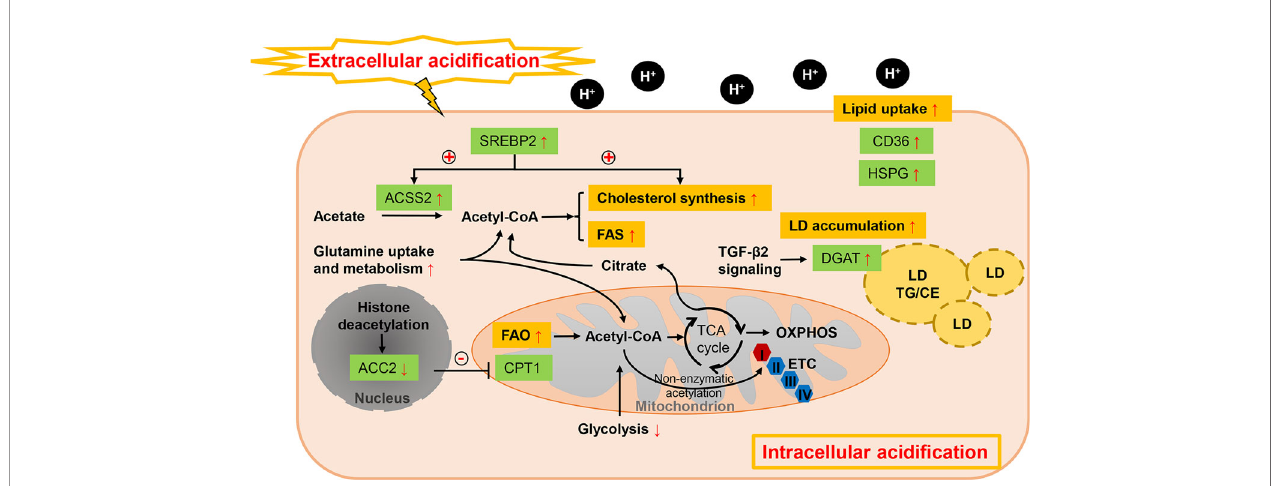
FIGURE 3 | Lipid metabolism reprogramming of cancer cells under acidosis. While glucose-derived acetyl-CoA is dramatically reduced, FA metabolism is profoundly altered in response to ambient acidosis with a shift toward FAO as a main source of acetyl-CoA to support TCA cycle and downstream lipid synthesis pathways and exogenous uptake of lipids is also enhanced. Different with the hypoxia condition, FAO and FAS could co-exist in acidosis-adapted cancer cells, which is orchestrated by restraining the ETC complex I activity and repressing histone deacetylation-mediated ACC2. Cholesterol biosynthesis is also enhanced by pH- induced SREBP2 to maintain cellular cholesterol level under low pH. Meanwhile, acetate and glutamine act as critical substrates in acidic milieu. LD formation is favored in acidic pH via TGF- b 2 mediated overexpression of DGAT1. “ + ” in circle means positive effects and “ - ” in circle stands for